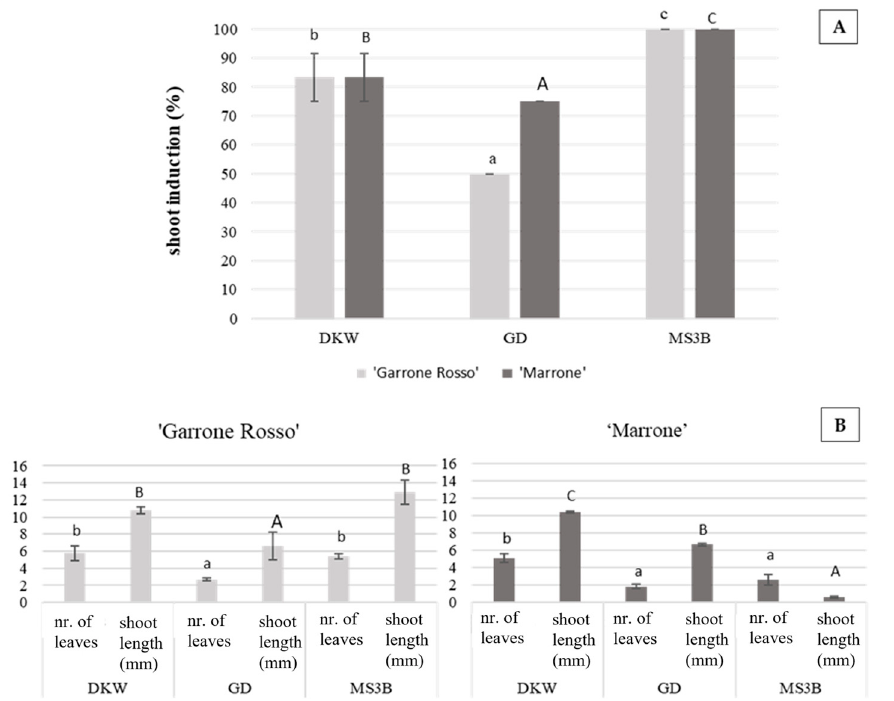
Figure 4. ( A ) Percentage of new induced shoots in cultivars ‘Garrone Rosso’ and ‘Marrone di Castel del Rio’. ( B ) Morphological traits of ‘Garrone Rosso’ and ‘Marrone di Castel del Rio’ in the three establishment media tested. Data are the means of three biological replicates (15 shoots each) ± SE. For each cultivar, means with the same letter do not significantly differ at p ≤ 0.05 (Tukey’s HSD test). Lowercase letters and capital letters were used to indicate nr. of leaves and shoot length respectively.